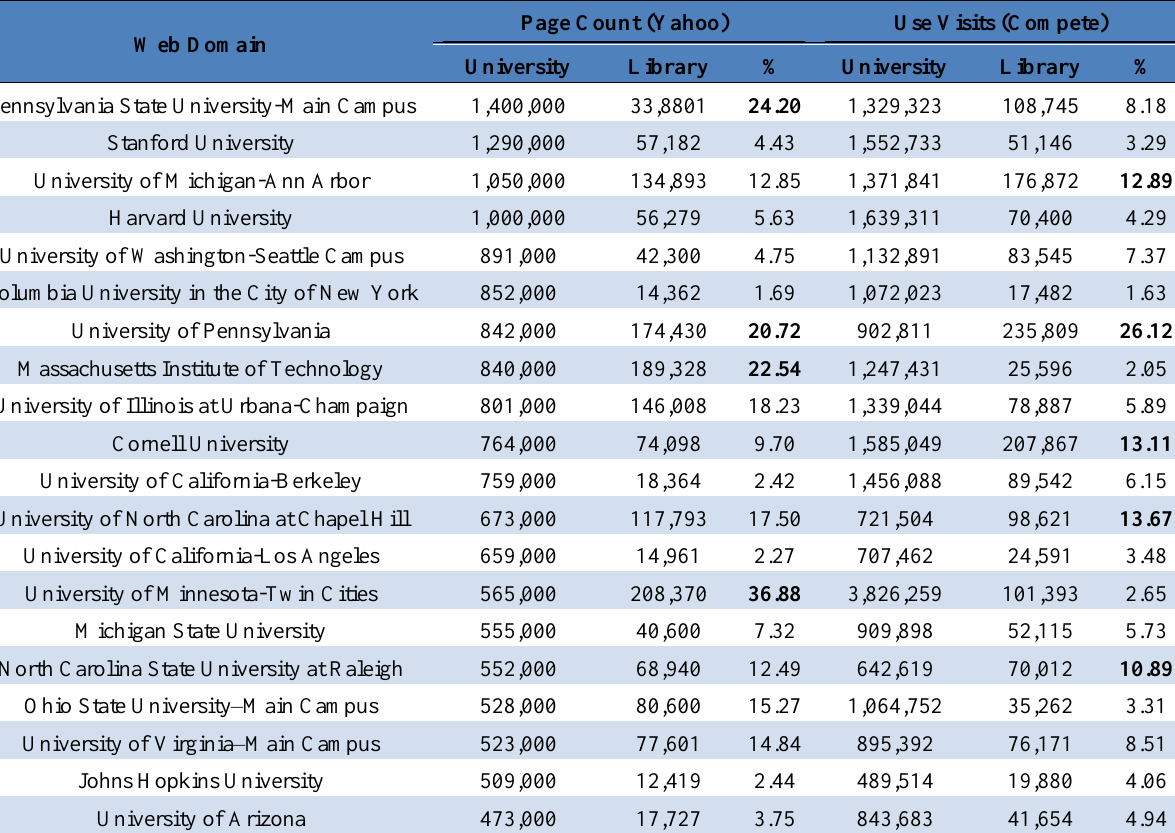
Table 6. Percentage of library web data of total university web data. Web